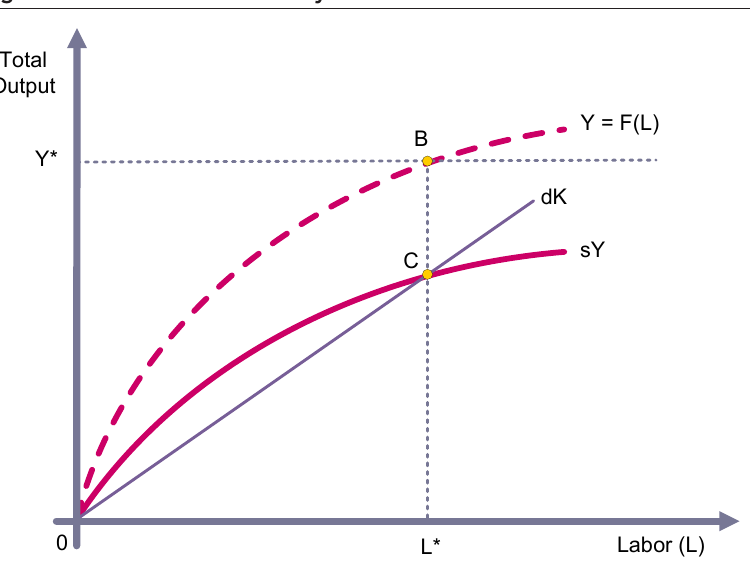
Figure 1. The neoclassical steady state